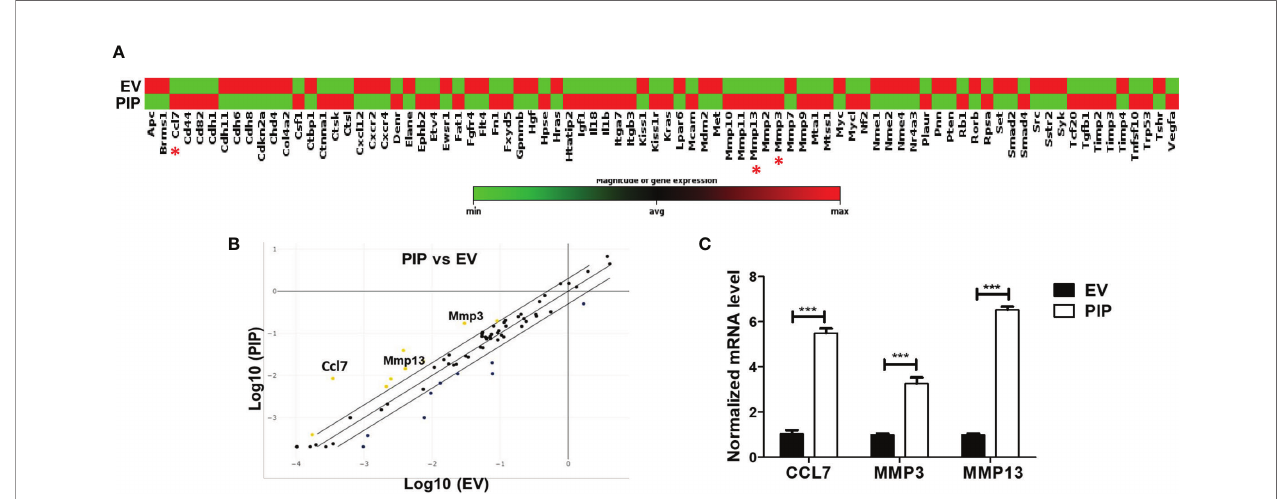
FIGURE 7 | PIP expressing 4T1 cells upregulate the expression of CCL7, MMP3, and MMP13. A qPCR array analysis of mouse tumor metastasis genes was performed in 4T1-PIP and 4T1-EV cells prior to injection into mice (denoted as PIP and EV). (A) shows the gene expression pro fi le of 4T1-PIP and 4T1-EV cells, with CCL7, MMP3 and MMP13 marked with red asterisk. The data in (A) represents single samples. (B) is a scatter plot representing the relative expression of metastasis genes by 4T1-PIP cells compared to 4T1-EV cells with a threshold of two-fold upregulation (yellow dots) or down regulation (dark blue dots). The genes for CCL7, MMP3 and MMP13 (metastasis-related genes) showed consistent upregulation in 4T1-PIP cells and were selected for further validation by qPCR. (C) shows the normalized (relative to GAPDH) fold expression levels of MMP3, MMP13 and CCL7 in 4T1-PIP and 4T1-EV cells. Data are representative of two experiments and are shown as mean ± SEM. ***p < 0.001; two-way ANOVA was